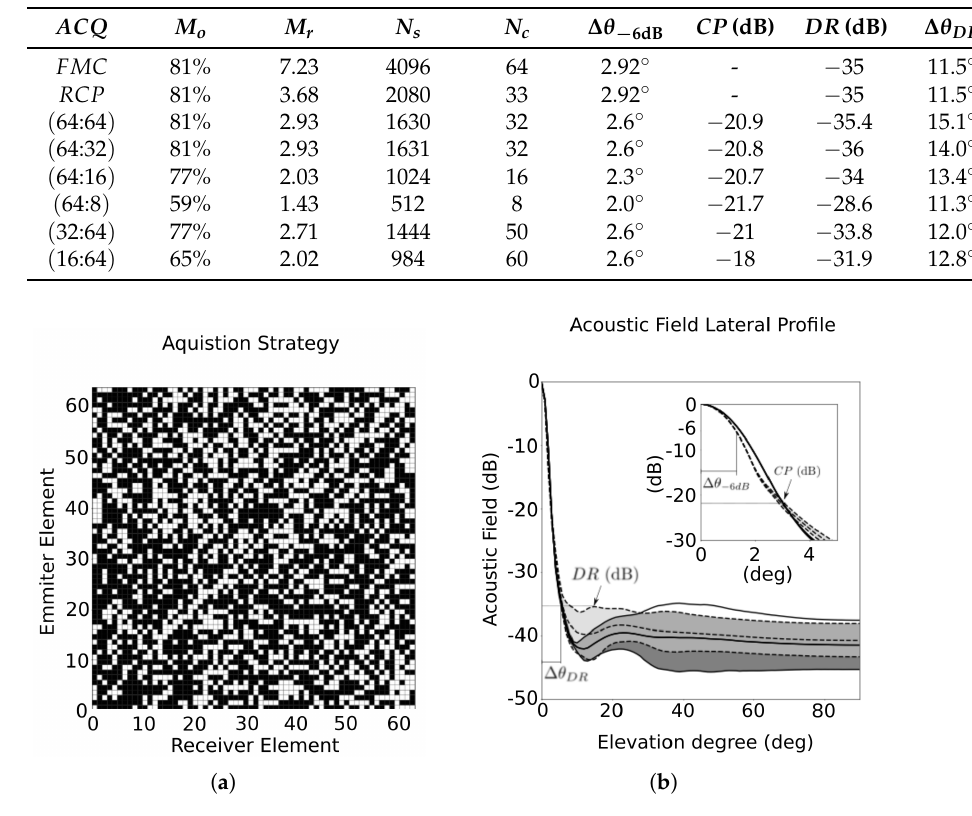
Figure 6. ( a ) Strategy ACQ ( 64:64 ) for redundancy reduction. ( b ) Sidelobe distribution at each elevation angle for strategy ACQ ( 64:64 ) (light grey area within the dashed lines) and the FMC (dark grey area within the solid